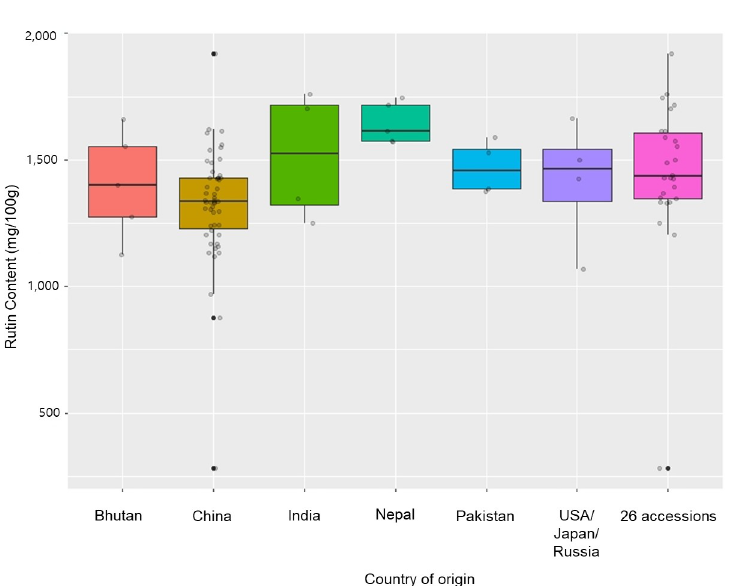
Fig 2. Rutin content of 73 tartary buckwheat accessions according to country of origin. The phenotypic segregation is shown in box-plot format. The interquartile region, median, and range are indicated by the box, the bold horizontal line, and the vertical line respectively. USA/Japan/Russia includes 4 accessions; 1 from the USA, 1 from Japan, and 2 from Russia. We selected 26 accessions for whole-genome resequencing that originated or were popularized in different Asian and international regions. For expanded details of the 73 tartary buckwheat accessions, see S1 Table.